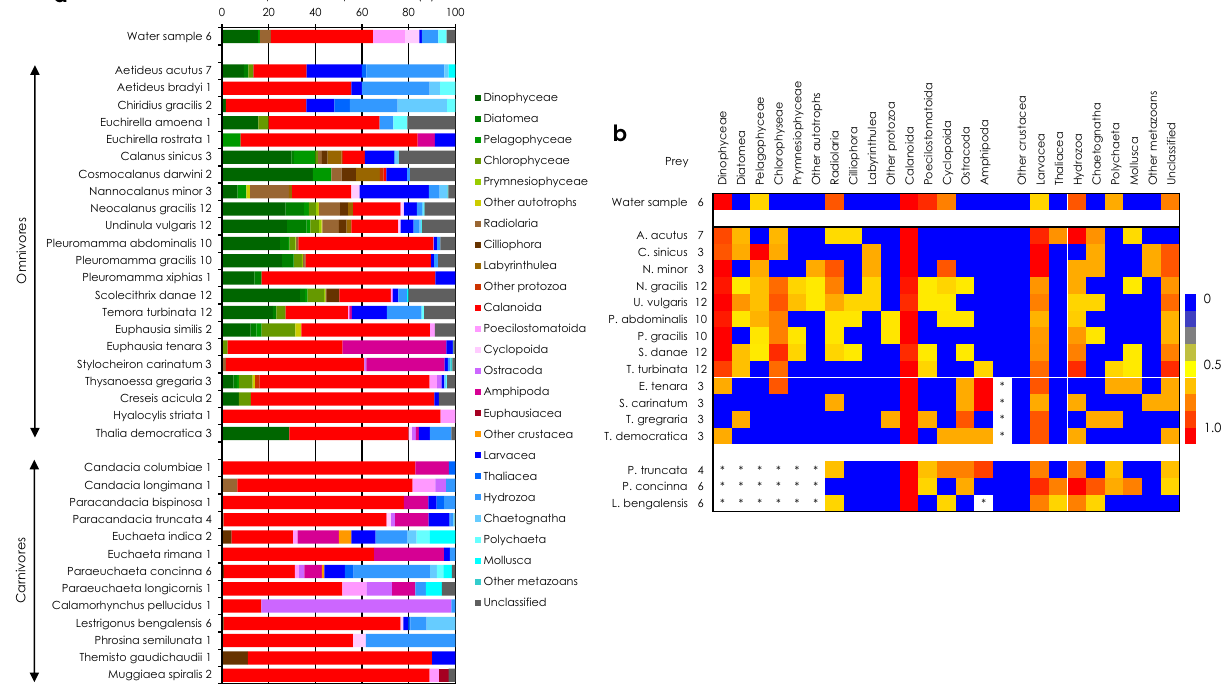
Figure 3. Average proportions of the standardized sequence reads ( a ) and a heatmap of average appearance frequency ( b ) for ten dominant prey OTUs from the DNA of ambient water samples (combined) and gut contents of mesozooplankton species in the Kuroshio in the East China Sea and its neighboring waters. Numbers beside group names are the number of replicates. Asterisks indicate eliminated prey